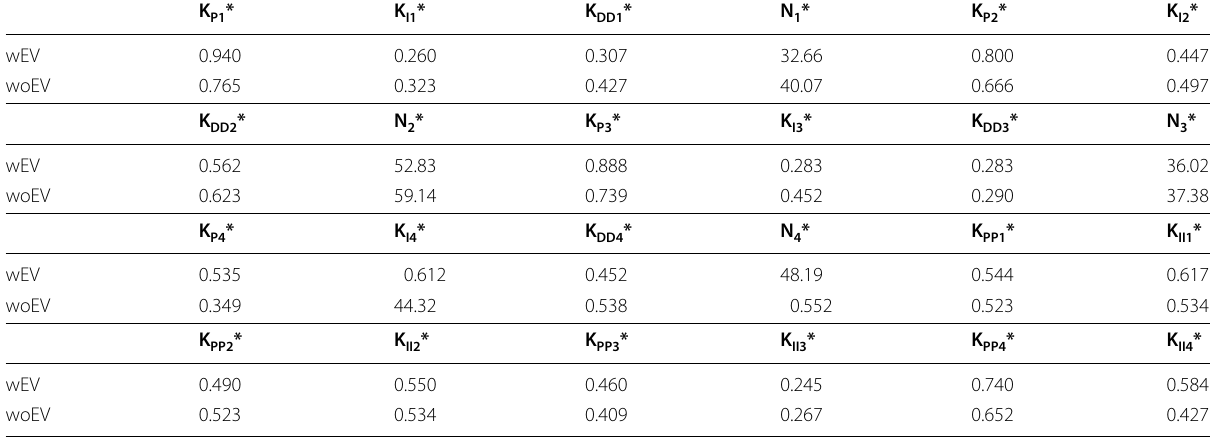
* represents optimum values for the PIDD - PI controller using Harris Hawk Algorithm